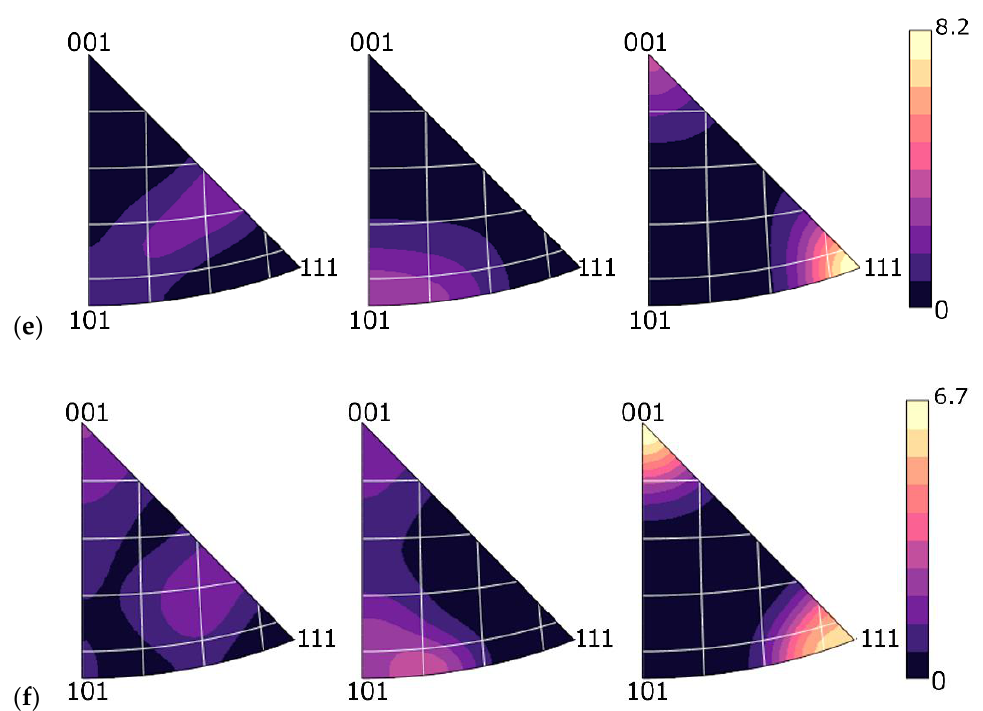
Figure 9. Inverse pole figures (IPFs) for Cu lamellas of swaged clad composites: ( a )20 mm; ( b )15 mm; ( c ) 10 mm; ( d ) IPFs for Al matrices of swaged clad composites: 20 mm; ( e ) 15 mm; ( f ) 10 mm.